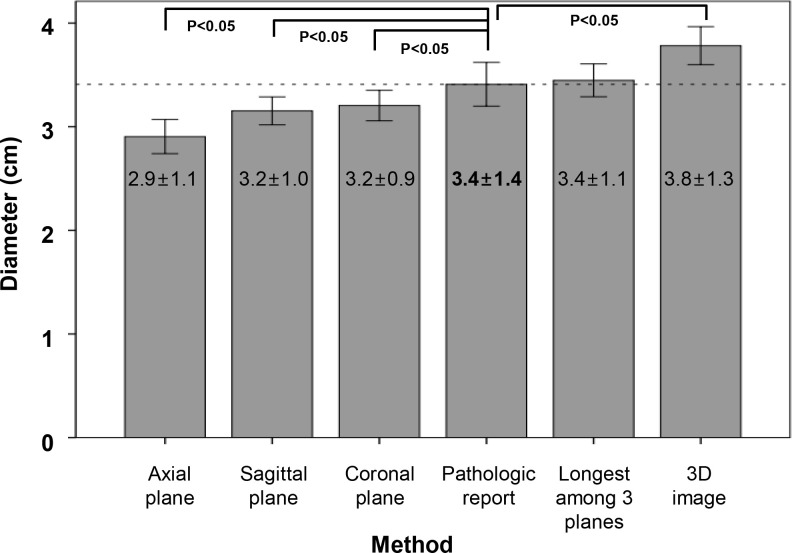
Comparison of pancreatic cancer diameters measured by various methods.Maximum tumor diameters measured in the axial, sagittal, and coronal CT planes were 2.9 ± 1.1, 3.2 ± 1.0, and 3.2 ± 0.9 cm, respectively.